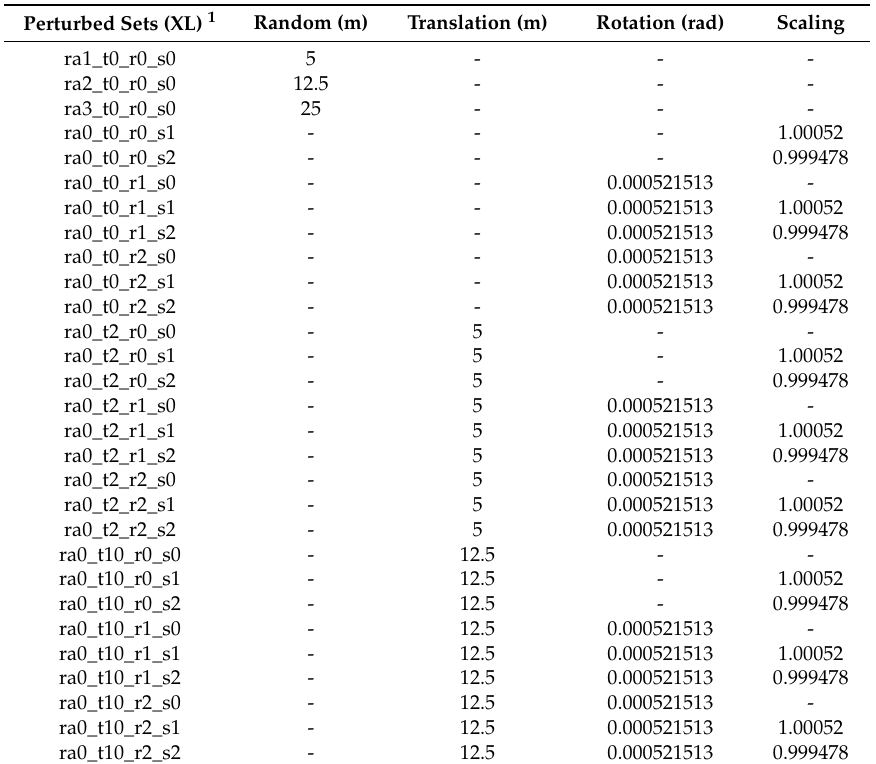
Table 2. Perturbed set of lines (XL) used in this application for CL1 to CL5 classes: random or systematic perturbations obtained from Matching